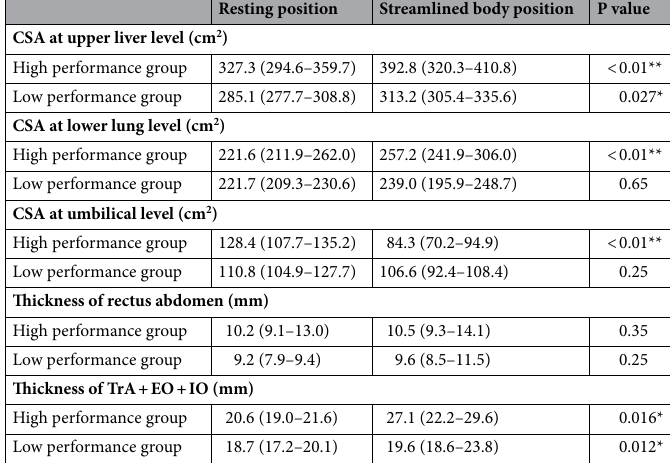
High performance group n = 5 Low performance group n = 5 P value